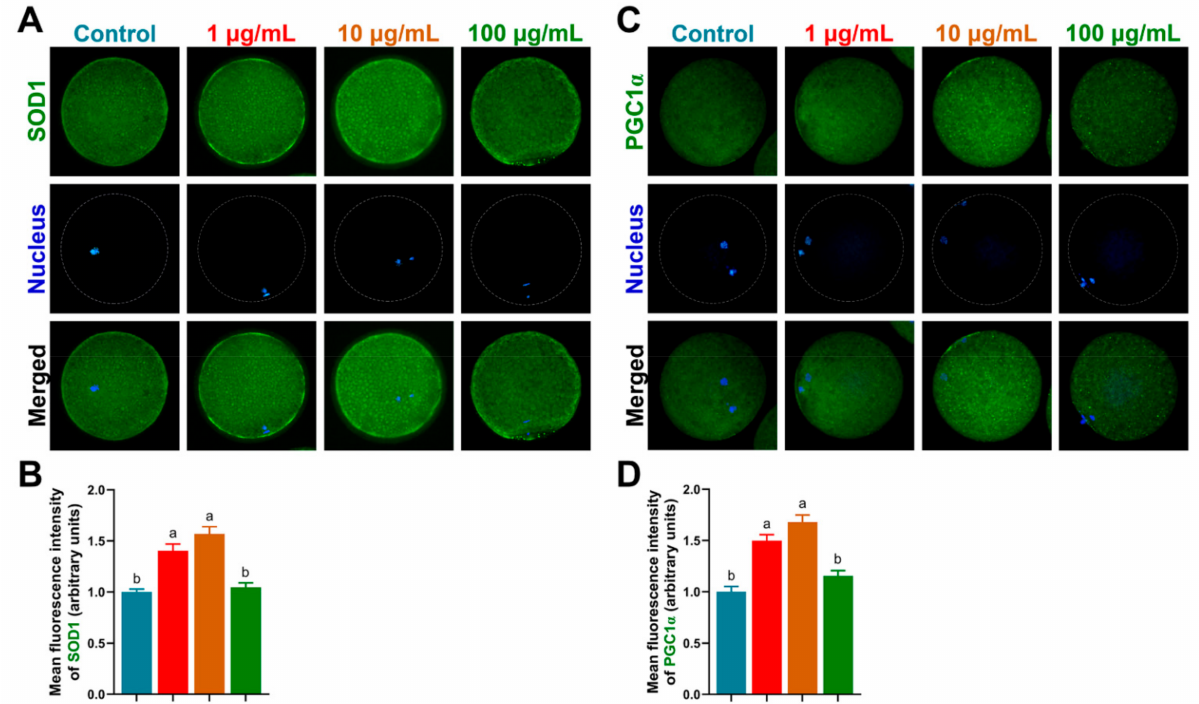
Figure 4. Protein levels of SOD1 and PGC1 α in porcine oocytes. ( A , B) SOD1 expression in oocytes. ( C , D ) PGC1 α expression in oocytes. Bars with different letters denote significant differences ( p < 0.05). Results are shown as the average ± SEM of at least three repeats of independent experiments.